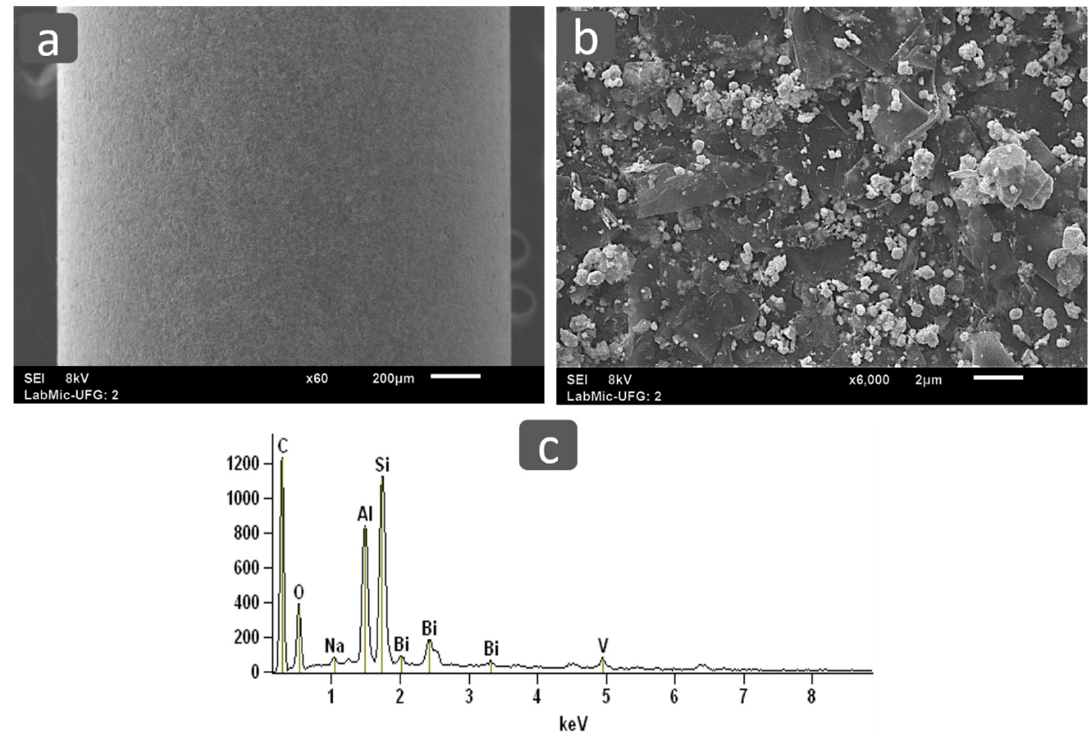
Figure 4. SEM images of pencil graphite surface: ( a , b ) after the deposition of BVO particles; ( c ) EDS spectrum indicating the composition of material after deposition.